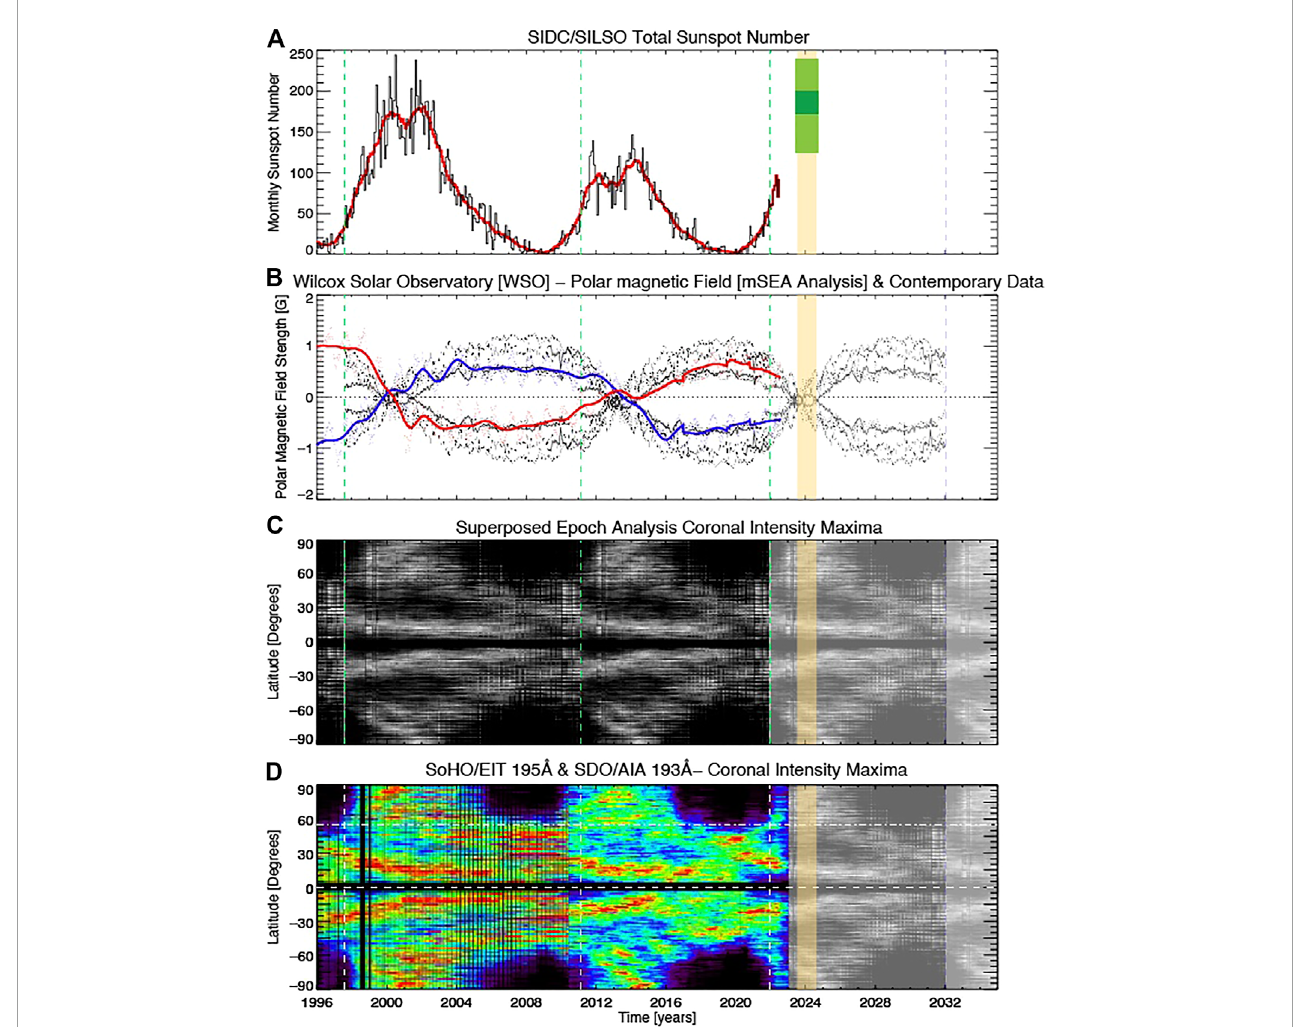
FIGURE 8 Panel (A) shows the monthly and 13-month smoothed (red) sunspot number. Panel (B) shows the Wilcox Solar Observatory solar polar magnetic field measurements and the modified superposed epoch analysis (mSEA) of the same data (see Figure 3 of L2022) extended into the future. Panel C shows the mSEA for the coronal global-scale intensity maxima of McIntosh et al. (2021) (see Figure 13). Panels and C use the terminator-to-terminator mSEA placed back onto the native timeline using the green vertical lines that indicate the Hale Cycle Terminators of SC22 through SC24. Panel (D) compares the contemporary coronal global-scale intensity maxima against the future data from Panel (C) . The vertical shaded gold bar running through all four panels corresponds to our estimate of the sunspot maximum of SC 25 based on the mSEA polar magnetic field reversal; the solid rectangles in panel (A) correspond to our estimate of maximum with 1 σ (dark) and 2 σ (light) uncertainties. The blue dashed line in late 2032 represents our current estimate for the termination of SC 25 if it were to be of average length.